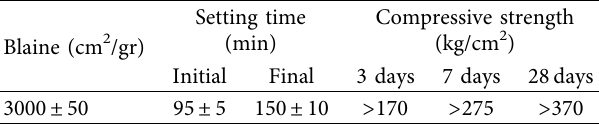
Table 3: Physical properties of cement.